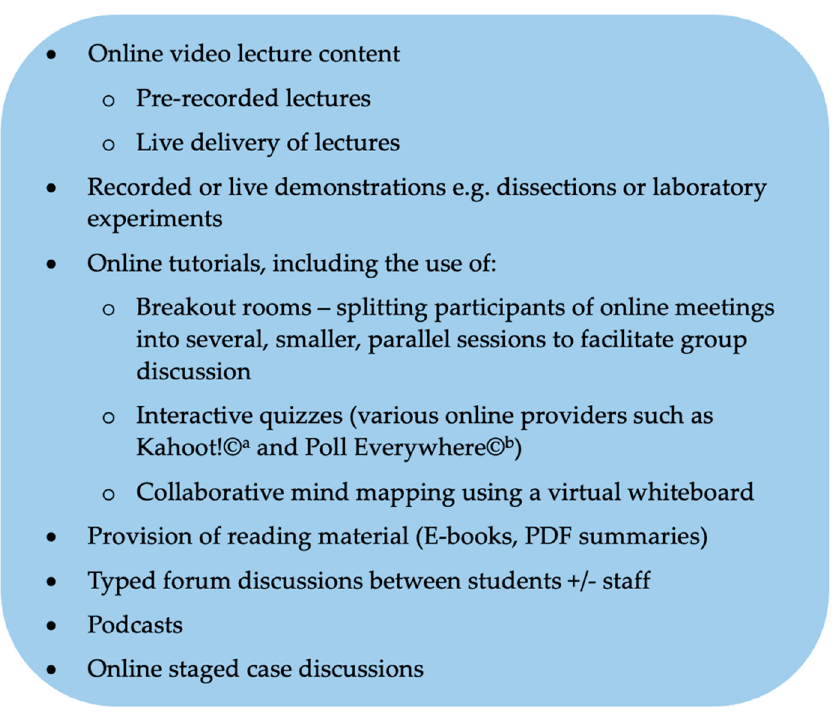
Figure 1. A non-exhaustive list of options for delivering theoretical content online. Kahoot!©-Tordenskiolds gate 6, 0160 Oslo, Norway. https://kahoot.com (accessed on 17 June 2021). Poll Everywhere Inc©-639 Howard Street, San Francisco, CA 94105 USA. https://polleverywhere.com (accessed on 17 June 2021).